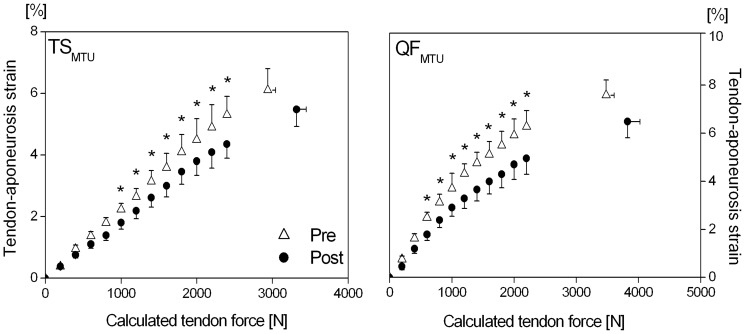
Tendon-aponeurosis strain of the gastrocnemius medialis (TSMTU) and vastus lateralis (QFMTU) at every 200 N of the calculated Achilles and patella tendon force during isometric maximal voluntary ankle plantarflexion and knee extension contractions determined before (pre) and after (post) the triceps surae and quadriceps femoris muscle-tendon unit exercise-intervention (means and SE).
*: Statistically significant differences between pre and post (P<0.05).